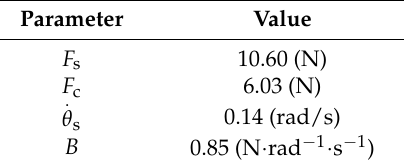
Table 4. Friction force parameters.